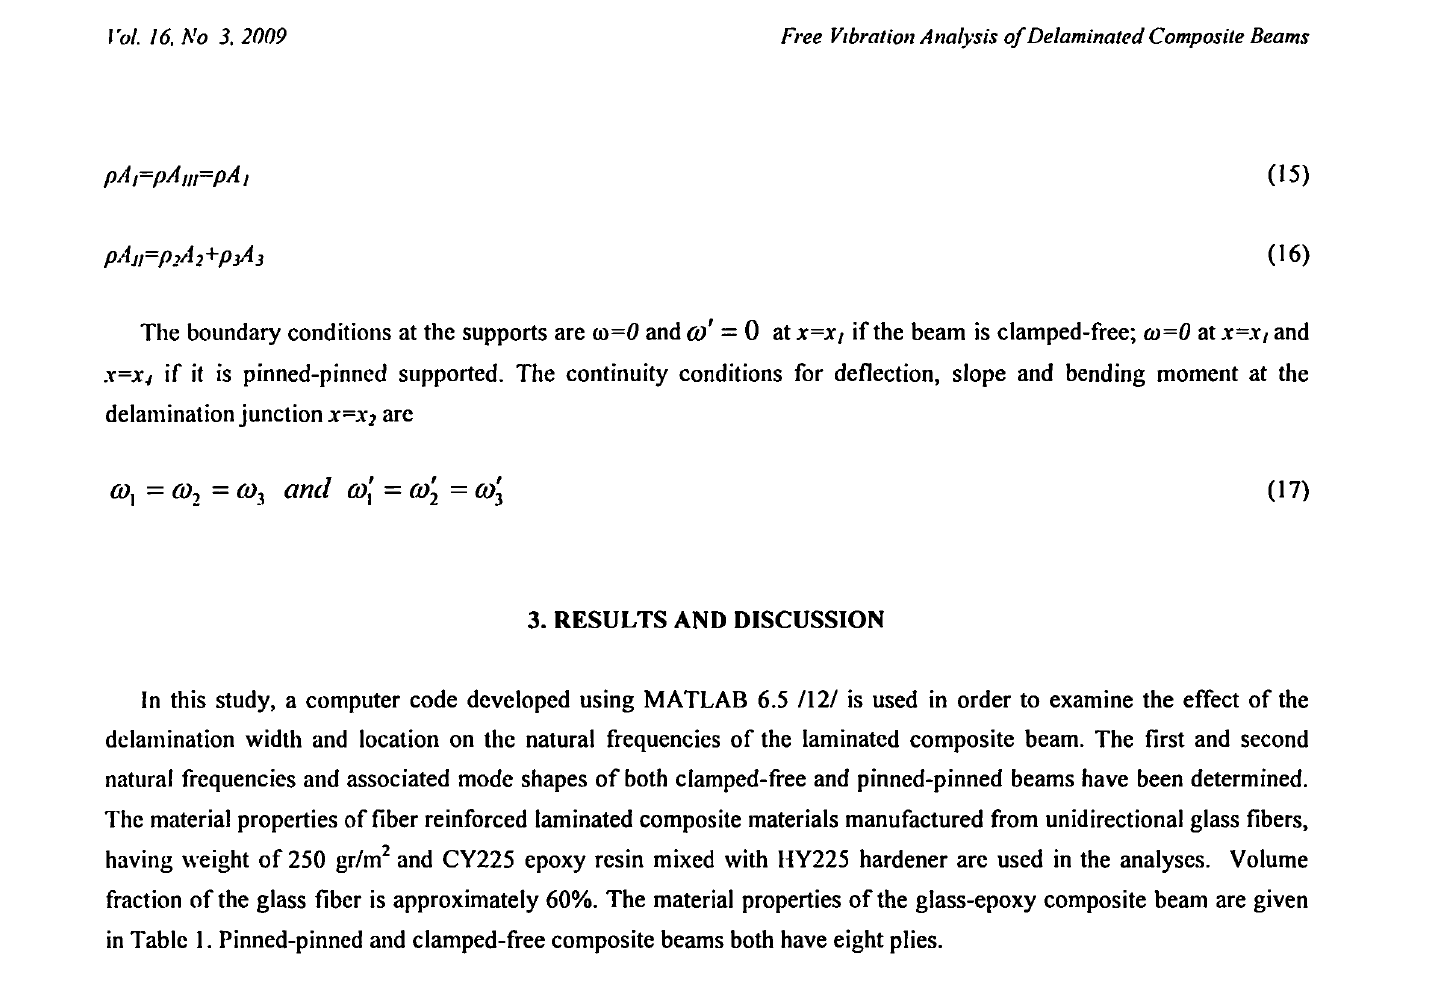
Material properties for